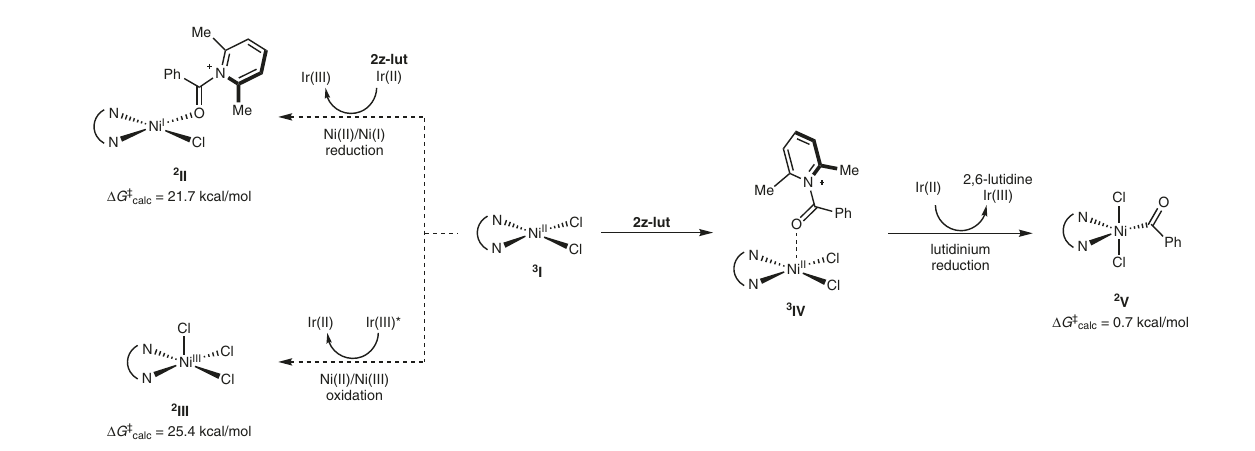
Fig. 5 | Computed redox properties of Ni(II) and N-acyllutidinium species. The reduction of Ni-coordinated N-acyllutidinium species 3 IV was computed to be